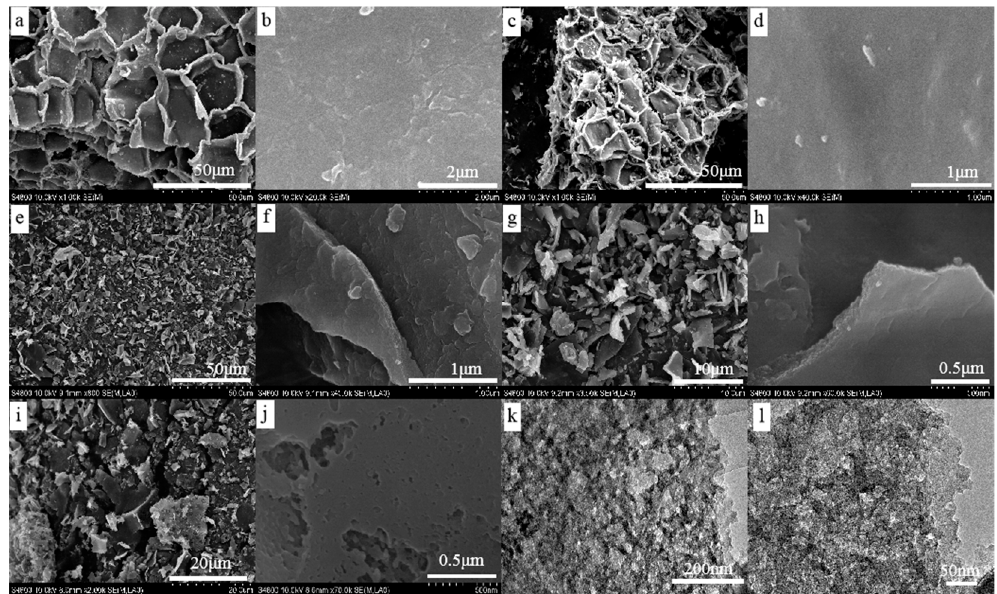
Figure 2. Scanning electron microscope (SEM) images of wood-derived carbon before and after air oxidation ( a , b ) raw materials, ( c , d ) C800, ( e , f ) C800-M350, ( g , h ) C800-M400, ( i , j ) C800-M450 and transmission electron microscope (TEM) images of C800-M450 ( k , l ).